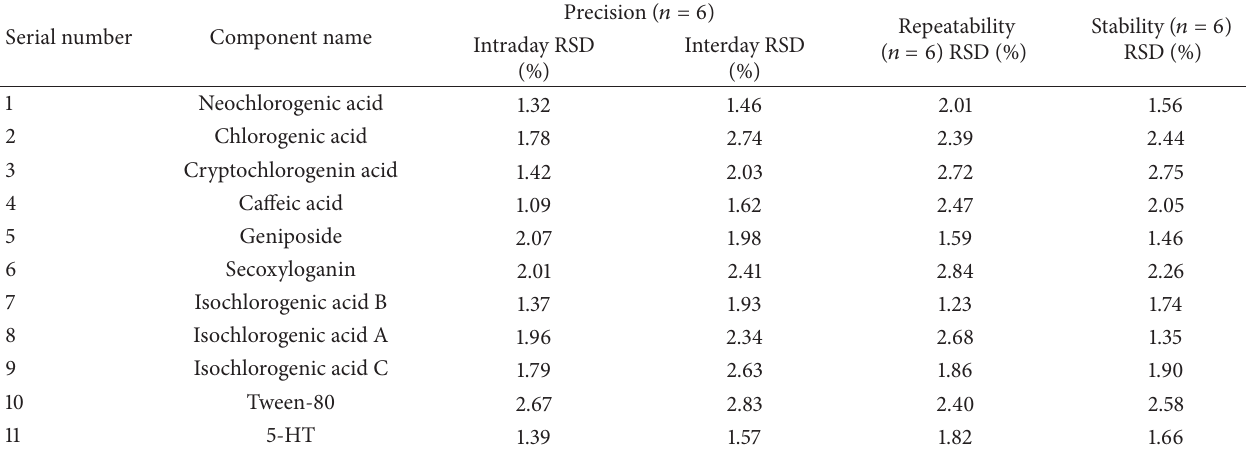
Table 3: Precision, repeatability, and stability of nine compounds ( 𝑛 = 6 ).